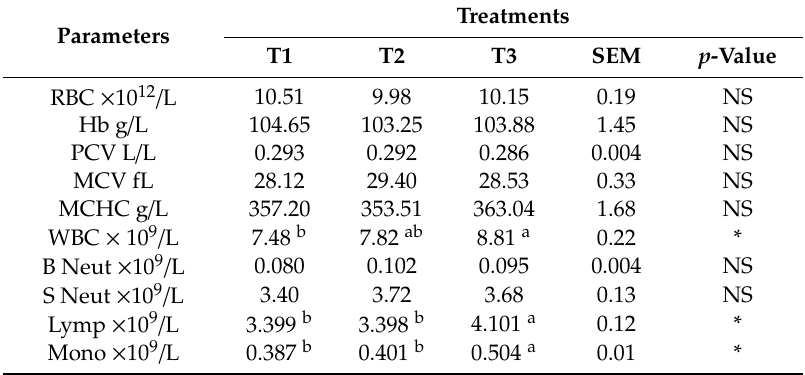
Table 6. The e ff ect of PKC-urea treated rice straw supplemented with di ff erent levels of corn on the hematological blood parameters in